Question: How would you classify this visualization?
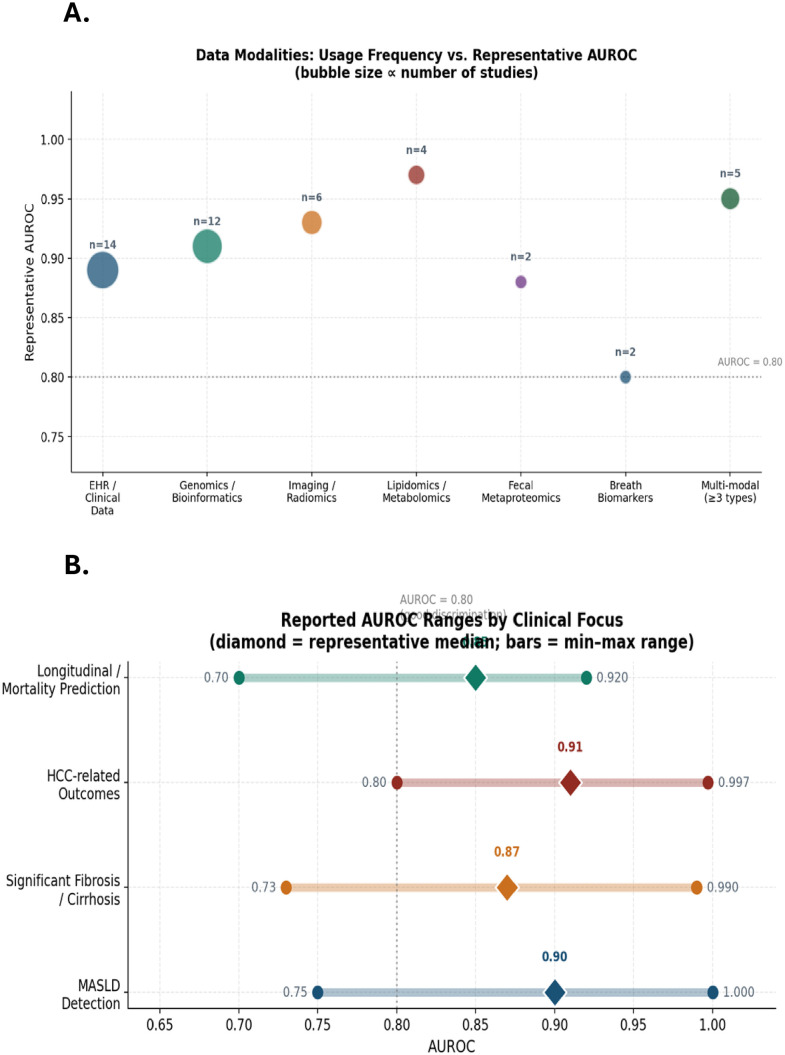
Answer: bar